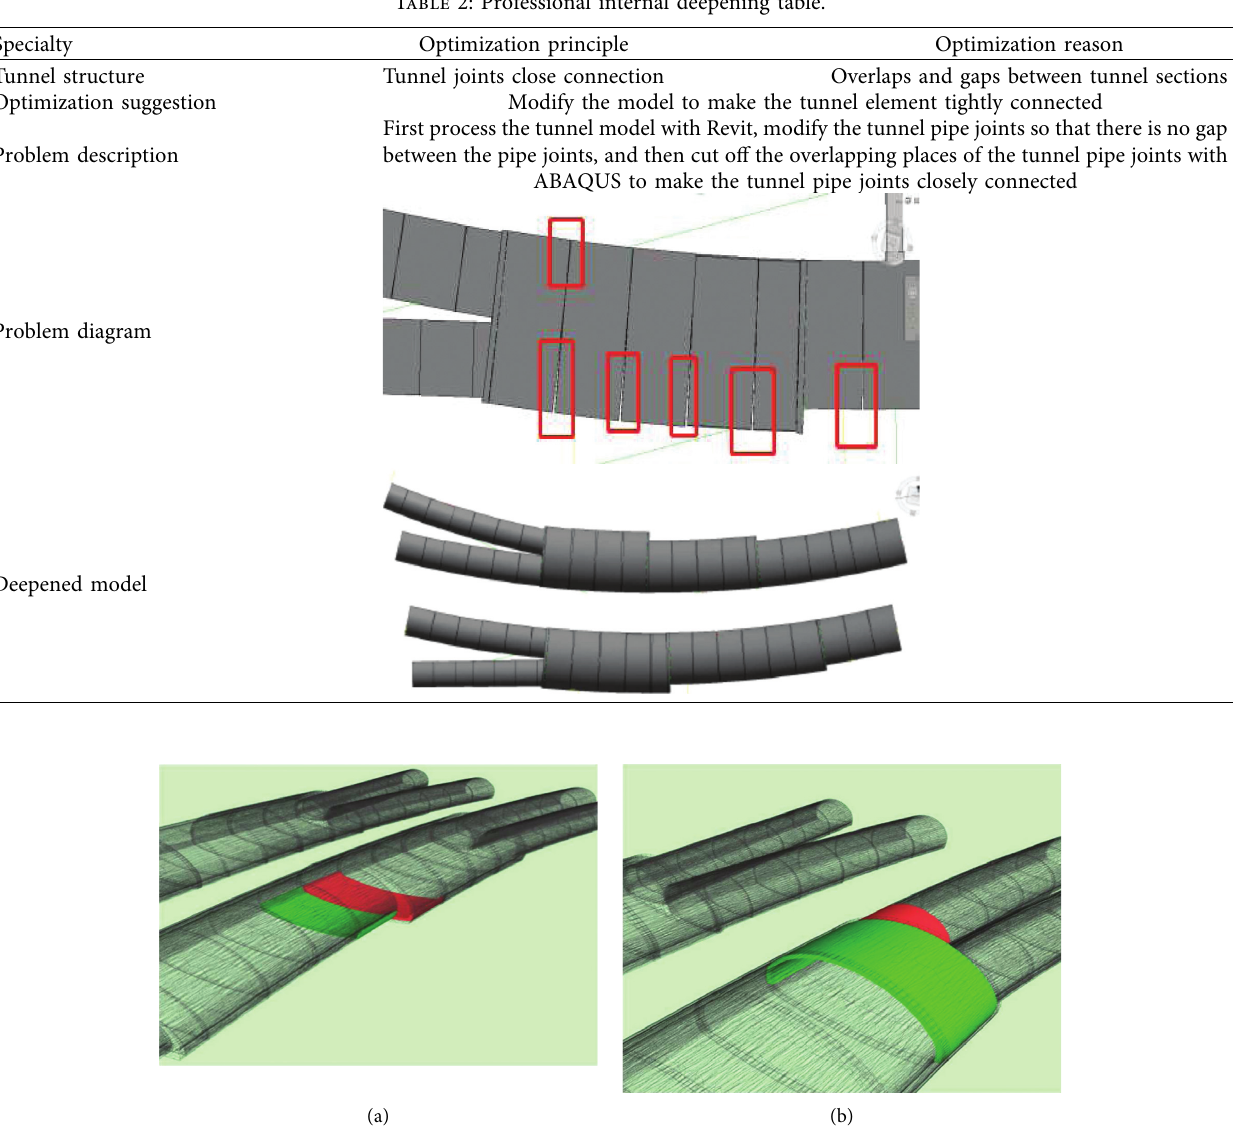
Figure 6: Impact member display: (a) collision between sprayed arch wall and arch wall lining; (b) collision between invert arch lining and sprayed arch wall.